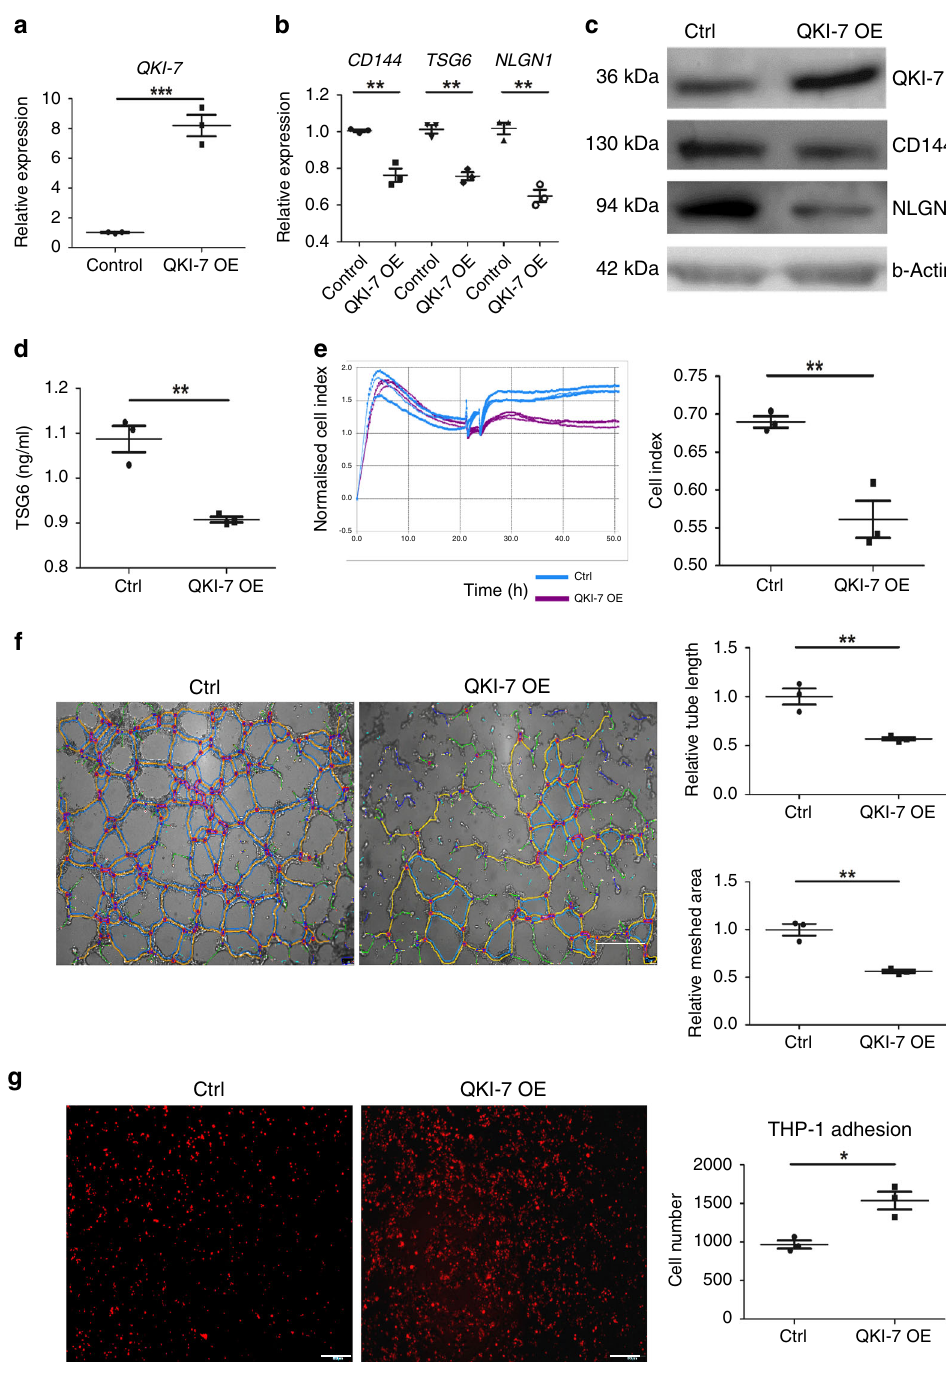
Fig. 2 QKI-7 affected genes/proteins expression and EC functions. QKI-7 overexpression ( p value: 0.0006) in miPS-ECs led to downregulation of EC function-related genes CD144, TSG6, and NLGN1 ( p values: 0.0027, 0.0012, 0.0014) ( a , b ). Protein level alteration of QKI-7 and target candidates was veri fi ed by western blot from three independent experiments ( c ) and ELISA ( p value: 0.0038) ( d ). QKI-7 overexpressing miPS-ECs showed decreased cell index with xCELLigence real-time cell analysis (RTCA) indicating disrupted cell barrier and increased permeability ( p value: 0.0073) ( e ). In tube formation assay, QKI-7 overexpressing miPS-ECs formed less capillary structure than control cells, measured by shorter tube branch length and smaller meshed area ( p values: 0.0069, 0.0024) ( f ). QKI-7 overexpression enhanced THP-1 adhesion to miPS-ECs ( p value: 0.0107) ( g ), the data were normalized by setting the control group as 1. Data are from three biologically independent experiments. Error bars represent mean ± SEM ( n = 3), * p < 0.05, ** p < 0.01, *** p < 0.001 (two-tailed t test). The source data are provided as a Source data fi